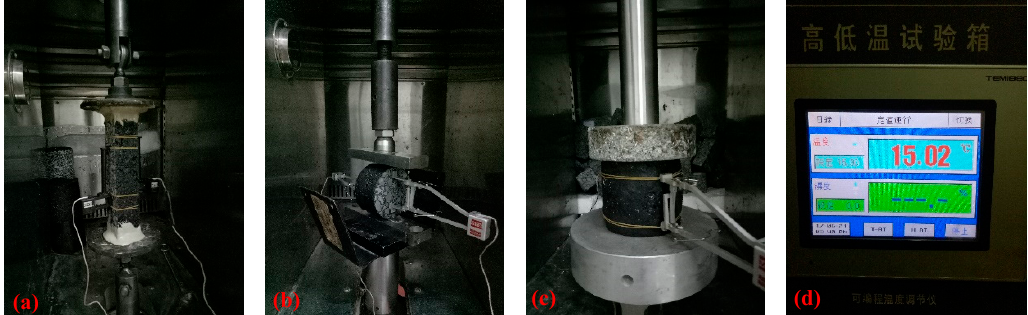
Figure 2. Testing process of strength under different loading modes: ( a ) direct tension test, ( b ) indirect tension test, ( c ) unconfined compression test, and ( d ) the environmental chamber.